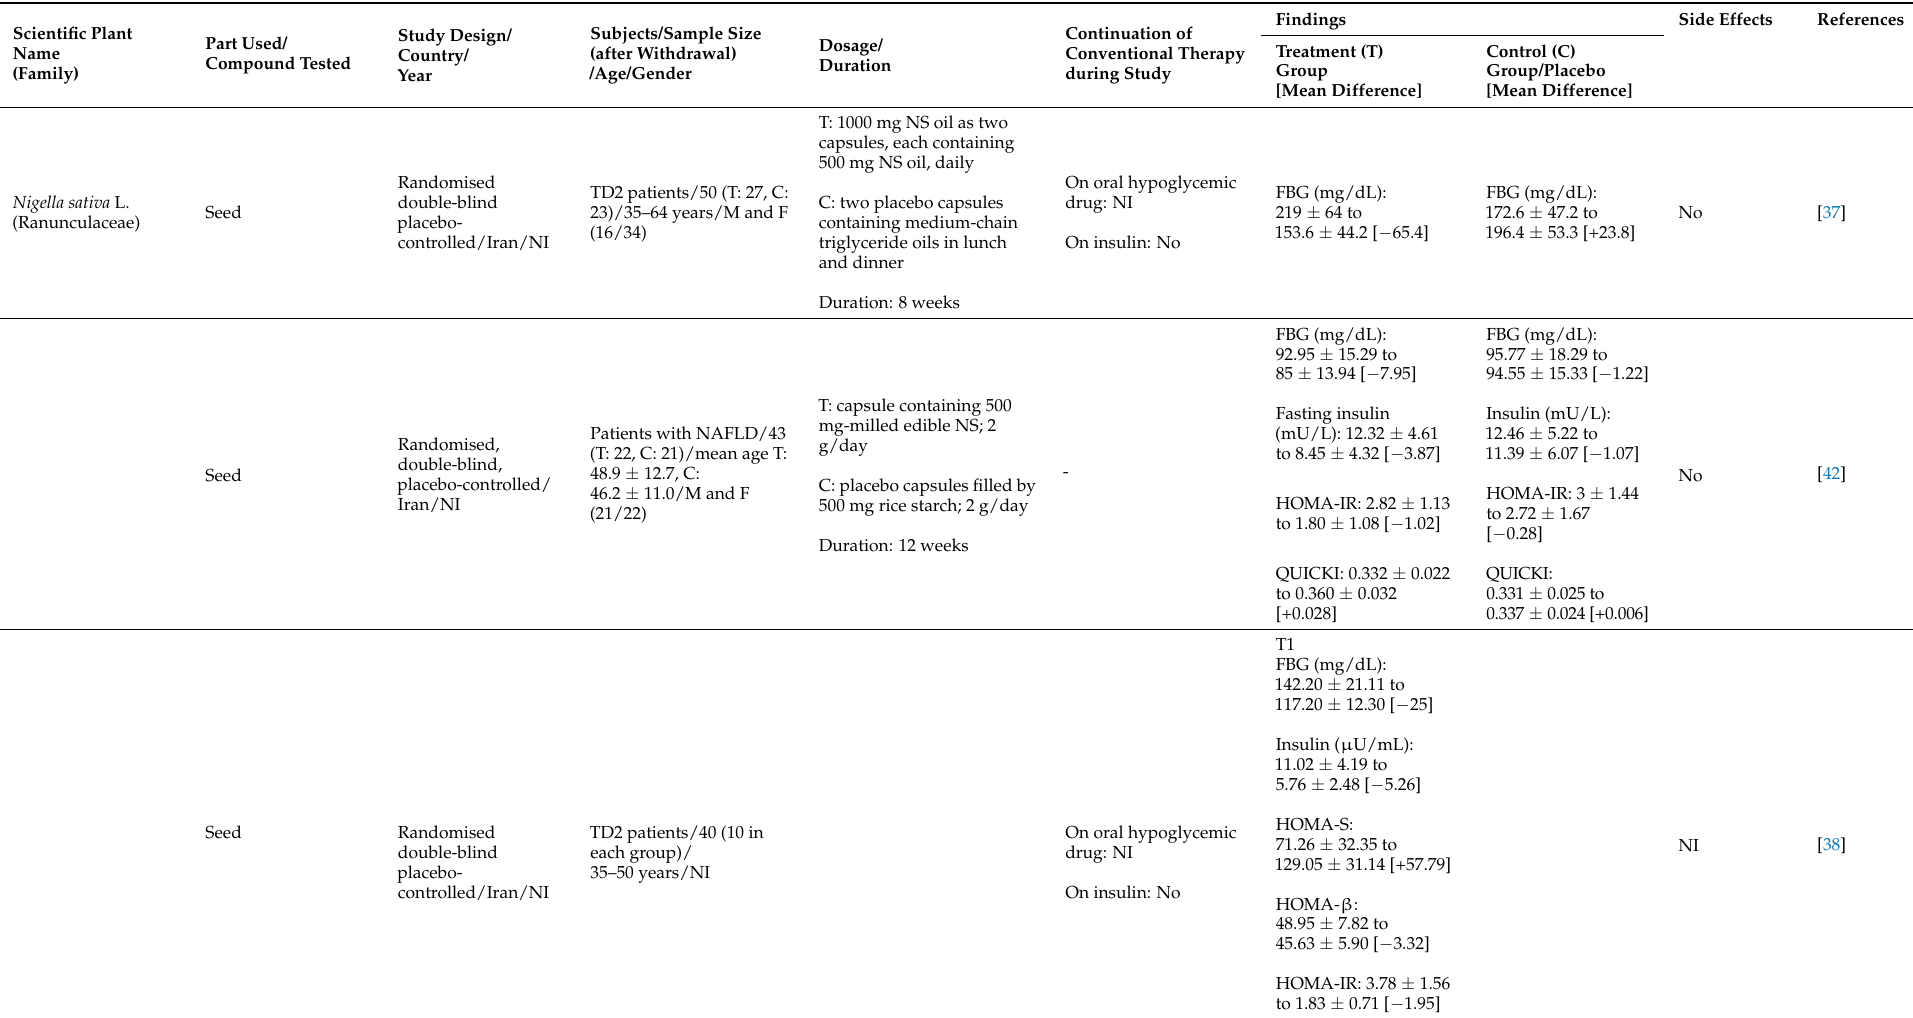
Table 2. Clinical studies of Nigella sativa L. and its compound TQ against